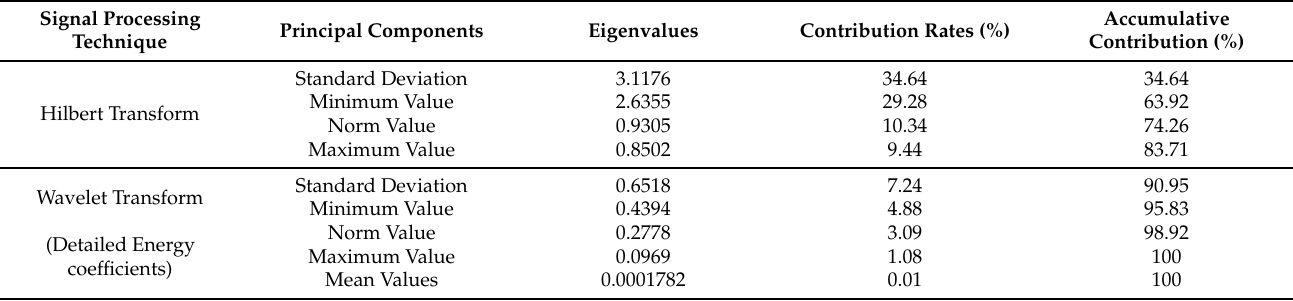
Table 4. Results of Principal Component